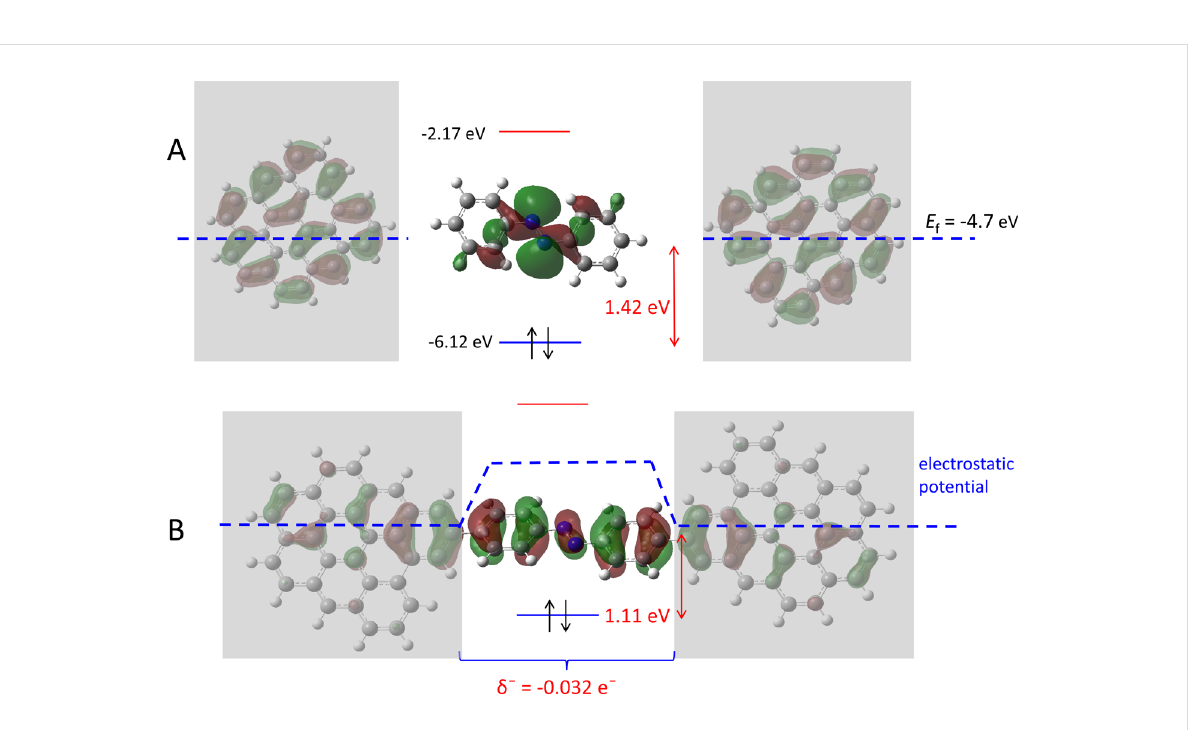
Figure 8: A) Isolated AB and G9 molecules showing the calculated HOMO and LUMO energies relative to the experimentally observed carbon Fermi level of − 4.7 eV. Also shown is the 1.42 eV tunneling barrier predicted from the free molecules. B. Schematic of electrostatic potential resulting from charge transfer of 0.032 e − to the AB molecule from the G9s accompanying covalent bond formation. The expected tunneling barrier is reduced to 1.11 eV, as shown.